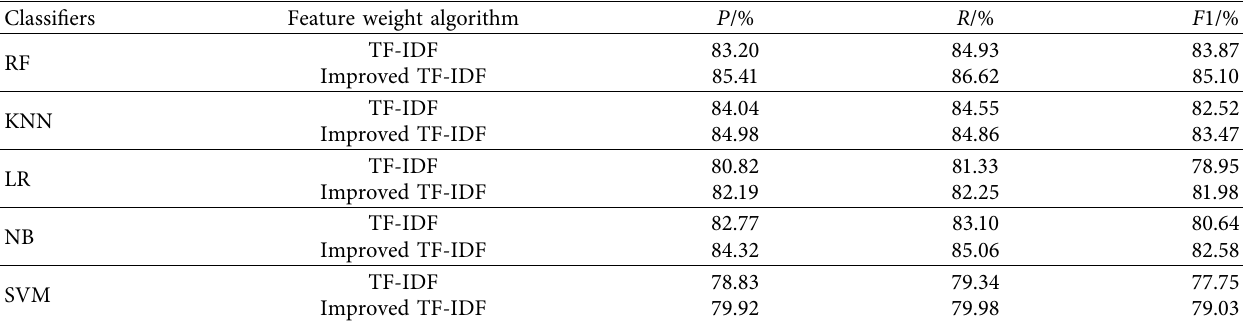
Table 3: Experimental results obtained by different classifiers.